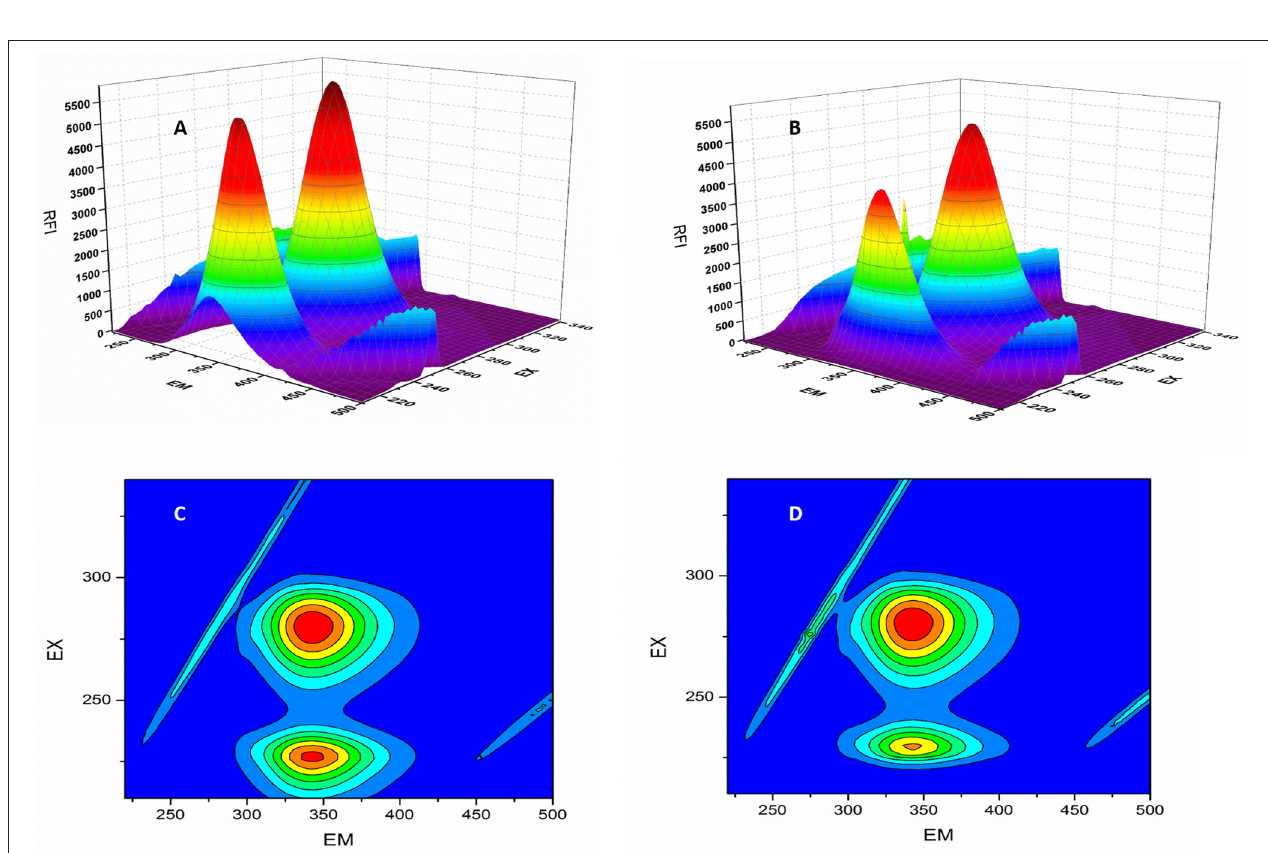
FIGURE 5 | 3D-spectroflurometric analysis of BSA and neratinib–BSA system. (A,B) are normal 3D spectra and (C,D) represent the contour plot of FI.